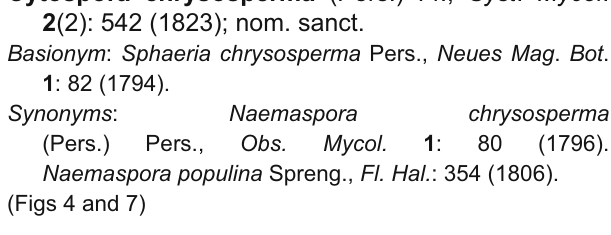
Description : Conidiomata on PDA pycnidial, mostly solitary, sometimes aggregated, globose to subglobose, without conceptacle, grey with off-white surface hyphae, (960–)1119– 1681(–2070) μm diam ( n = 20), with multiple internal locules with shared invaginated walls. Conidiophores some straight, (cid:7)(cid:4)(cid:6)(cid:13)(cid:2) (cid:10)(cid:13)(cid:21)(cid:5)(cid:19)(cid:13)(cid:21)(cid:2) (cid:8)(cid:4)(cid:2) (cid:12)(cid:10)(cid:9)(cid:17)(cid:19)(cid:14)(cid:11)(cid:17)(cid:25)(cid:2) (cid:20)(cid:23)(cid:9)(cid:6)(cid:13)(cid:17)(cid:8)(cid:4)(cid:5)(cid:7)(cid:2) (cid:19)(cid:4)(cid:17)(cid:11)(cid:21)(cid:11)(cid:4)(cid:25)(cid:13)(cid:17)(cid:4)(cid:5)(cid:7)(cid:2) cells that taper towards the apex (7.0–)7.2–8.8(–10.0) ×